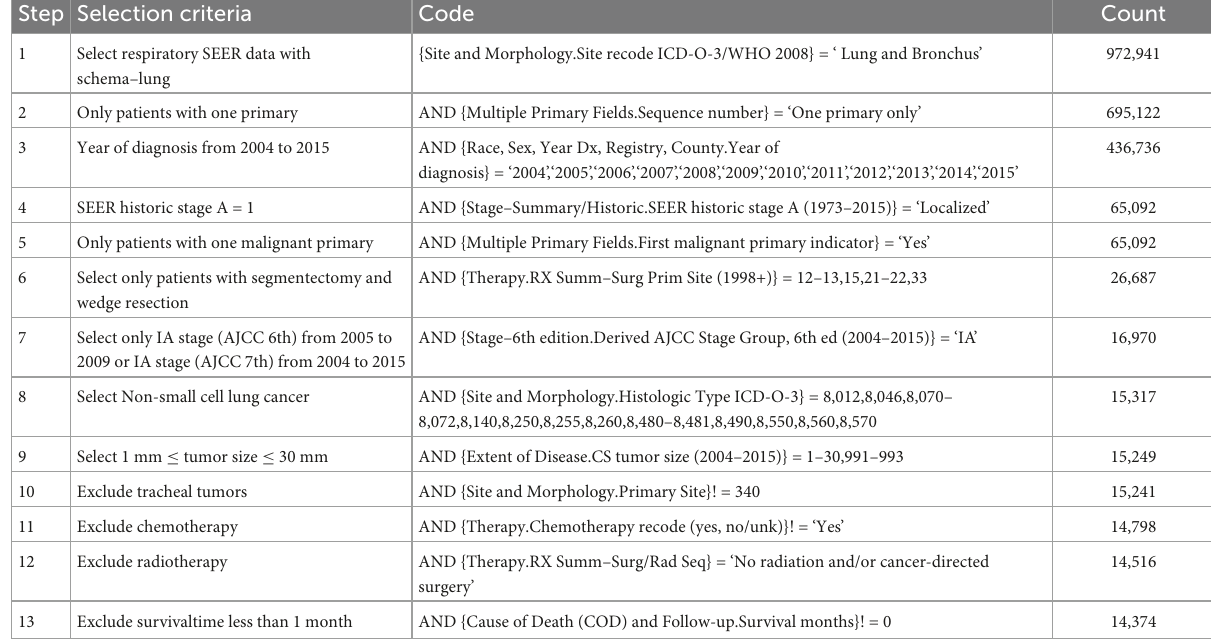
TABLE 1 Details patient selection criteria with variable names used and their effect on sample